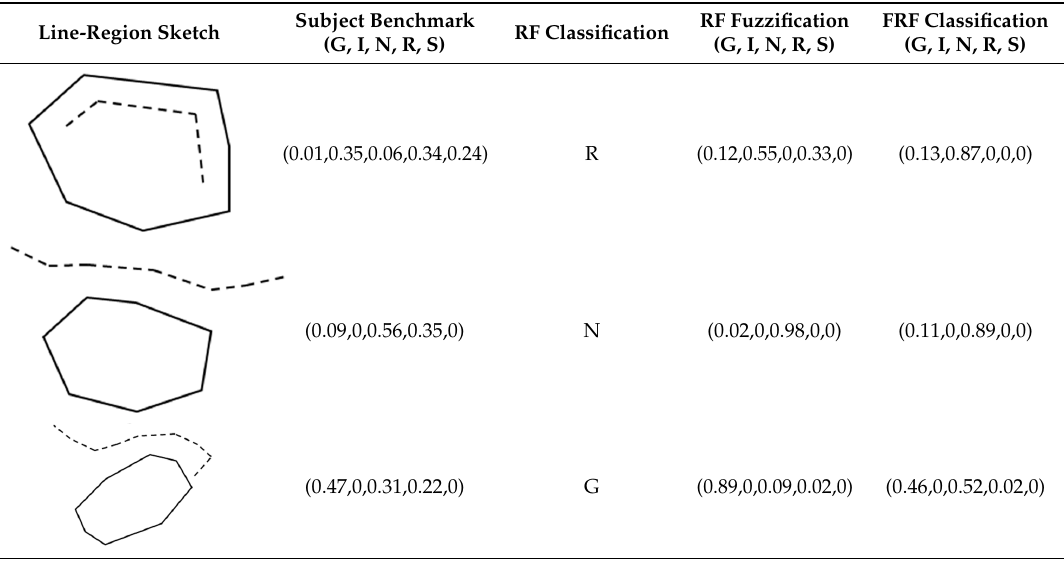
Table 7. Examples of line-region sketches and classification results.